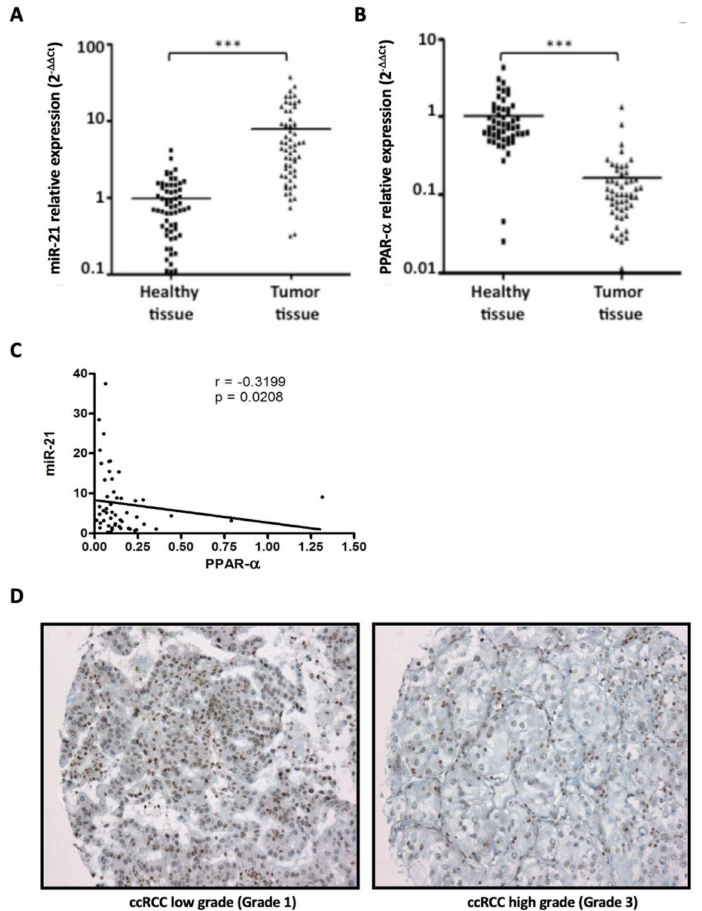
Figure 1. miR-21 is significantly upregulated and PPAR- α downregulated in ccRCC human tissues compared to the paired healthy tissues. ( A ) miR-21 and ( B ) PPAR- α expressions in the tumor and adjacent healthy renal tissues of a cohort of 52 cRCC patients were determined by qRT-PCR. RNU6B and PPIA were used as internal controls, respectively. The average expression of miR-21 and PPAR- α in ccRCC is shown in relation to the value obtained for normal kidney tissue (*** p < 0.001). ( C ) The correlation between miR-21 and PPAR- α expressions in ccRCC was analyzed with Spearman’s test. ( D ) The immunohistochemistry study preformed using an anti-PPAR- α antibody (magnification: ×